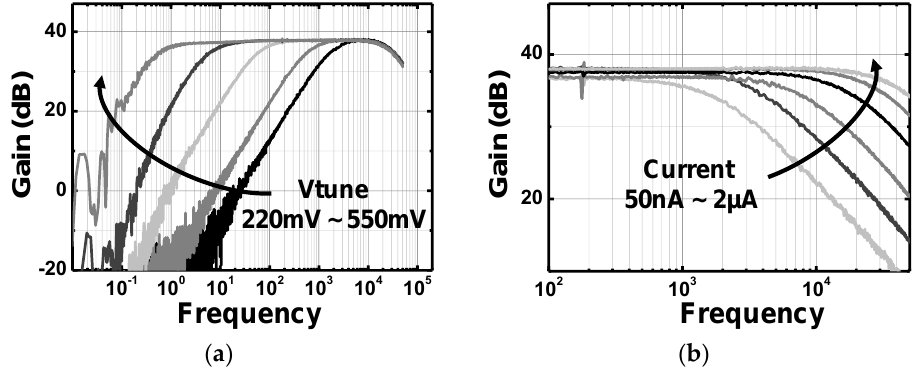
Figure 14. Measured frequency response of the LNA: ( a ) low frequency corner sweep and ( b ) high frequency corner sweep.